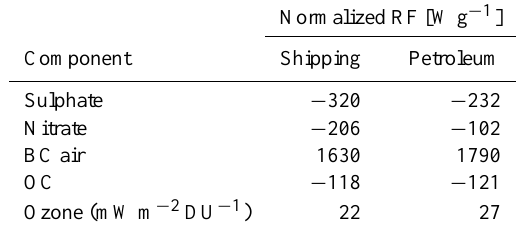
Table 3. Global Radiative Forcing normalized to annual, global change in atmospheric burden [Wg − 1 ] and [mWm − 2 DU − 1 ] for O 3 from ship and petroleum activity in